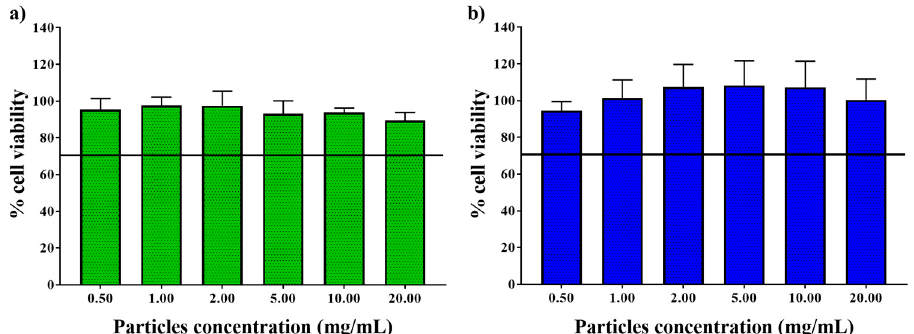
Figure 8. Cell viability in Caco-2 cells of Eudragit RS 100 ( a ) and Eudraguard ( b ) microparticles after incubation for 24 h. Data are presented as mean ± SD (N = 4). The black line sets the biocompatibility threshold percentage (70% viability).